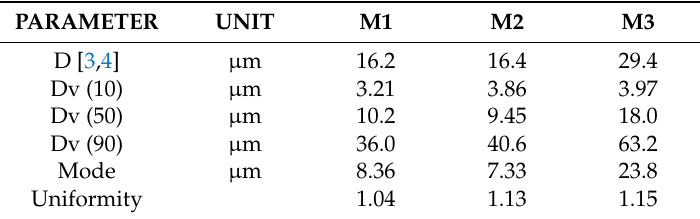
Table 2. The particle size